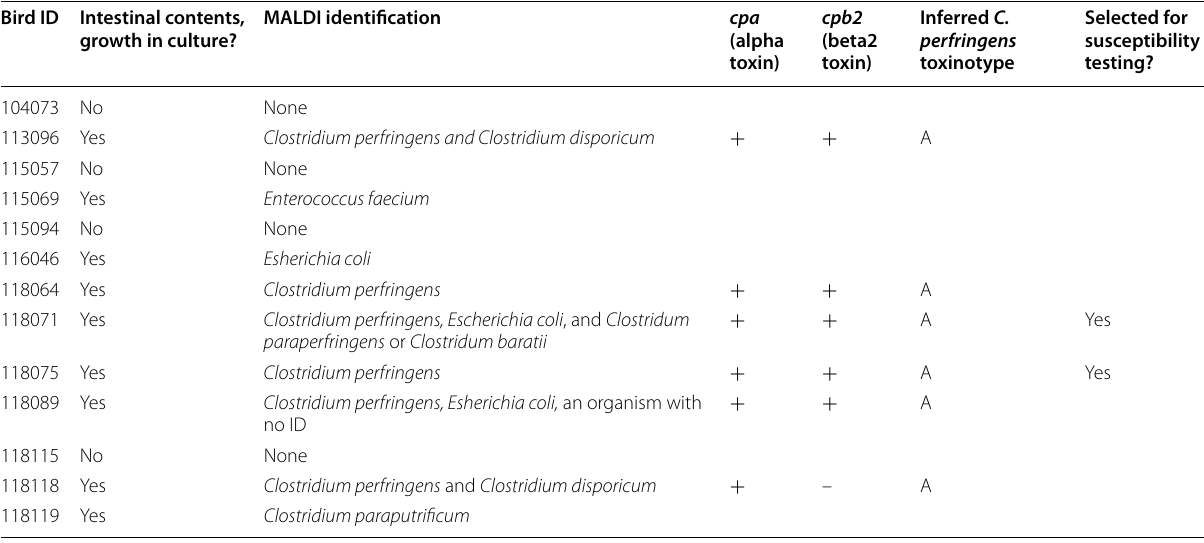
Table 2 Intestinal content isolates from CZA lorikeets Bird ID Intestinal contents, growth in culture?